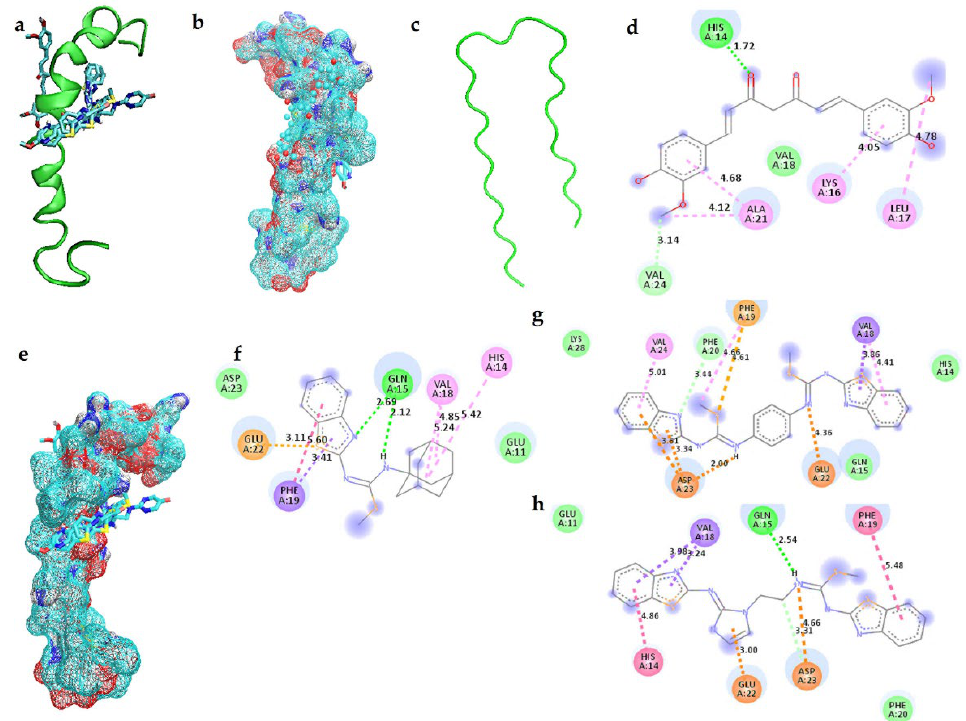
Figure 3. Non-bonded interactions obtained by docking simulations between Aβ 1-42 in α -helix and the compounds. ( a ) Curcumin and 3f , 3r and 3t compounds with the Aβ 1-42 in α -helix conformation. ( b ) Curcumin recognized a protein surface with less negative density in the Aβ 1-42 in α -helix confor- mation. ( c ) Aβ 1-42 in β -sheet conformation. ( d ) Aβ 1-42 in α -helix conformation and curcumin. ( e ) 3f , 3r and 3t compounds recognized a protein surface with less positive density in the Aβ 1-42 in α -helix conformation. Interactions of Aβ 1-42 in α -helix conformation and: ( f ) 3f compound; ( g ) 3r compound; ( h ) 3t compound.